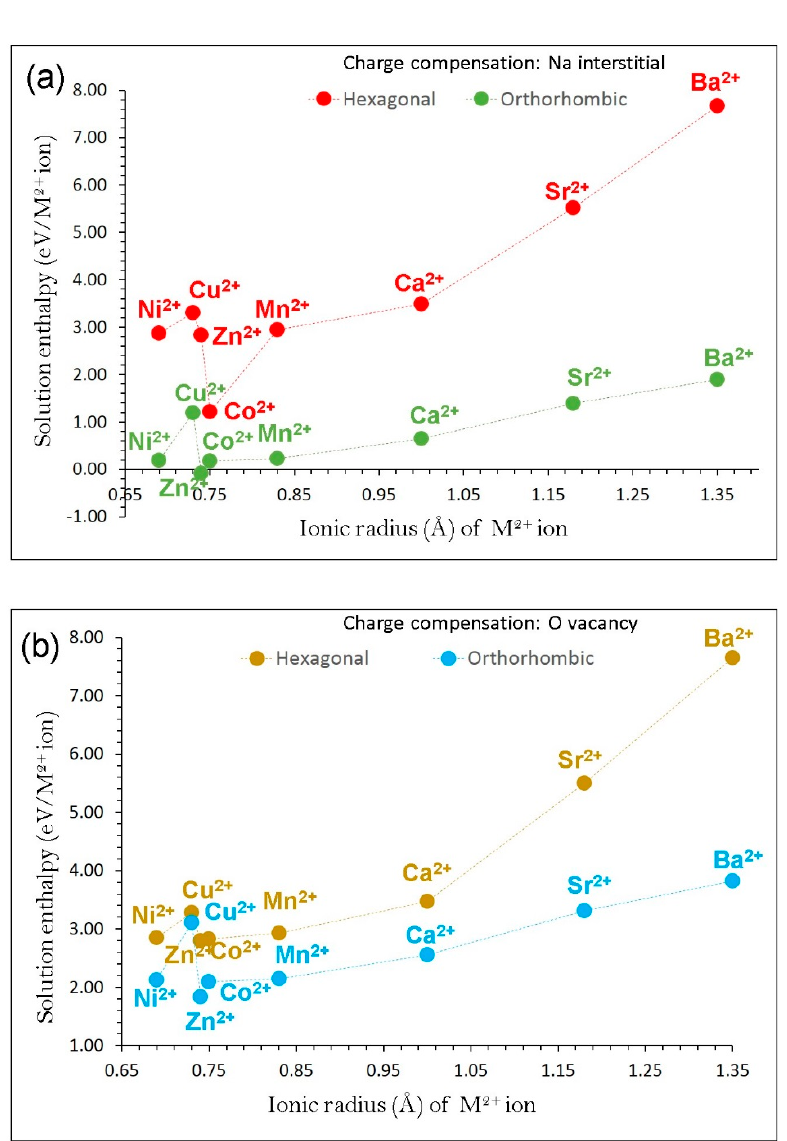
Figure 6. Calculated enthalpy of solution of MO (M = Ni, Cu, Zn, Co, Mn, Ca, Sr and Ba) with respect to the M 2+ ionic radius in NaFeO 2 using ( a ) Na interstitial and ( b ) O vacancy as charge compensation.